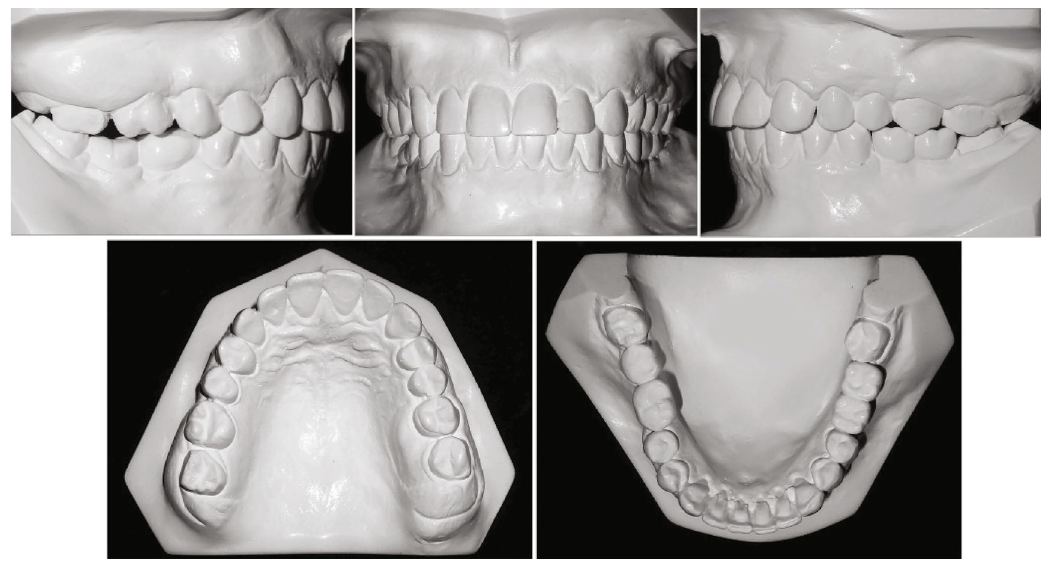
Figure 8: Posttreatment dental